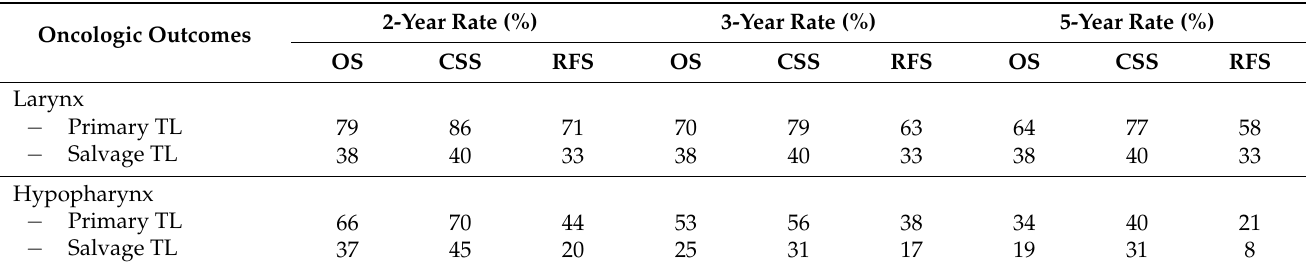
Table 2. Oncologic outcomes according to type of surgery and tumor